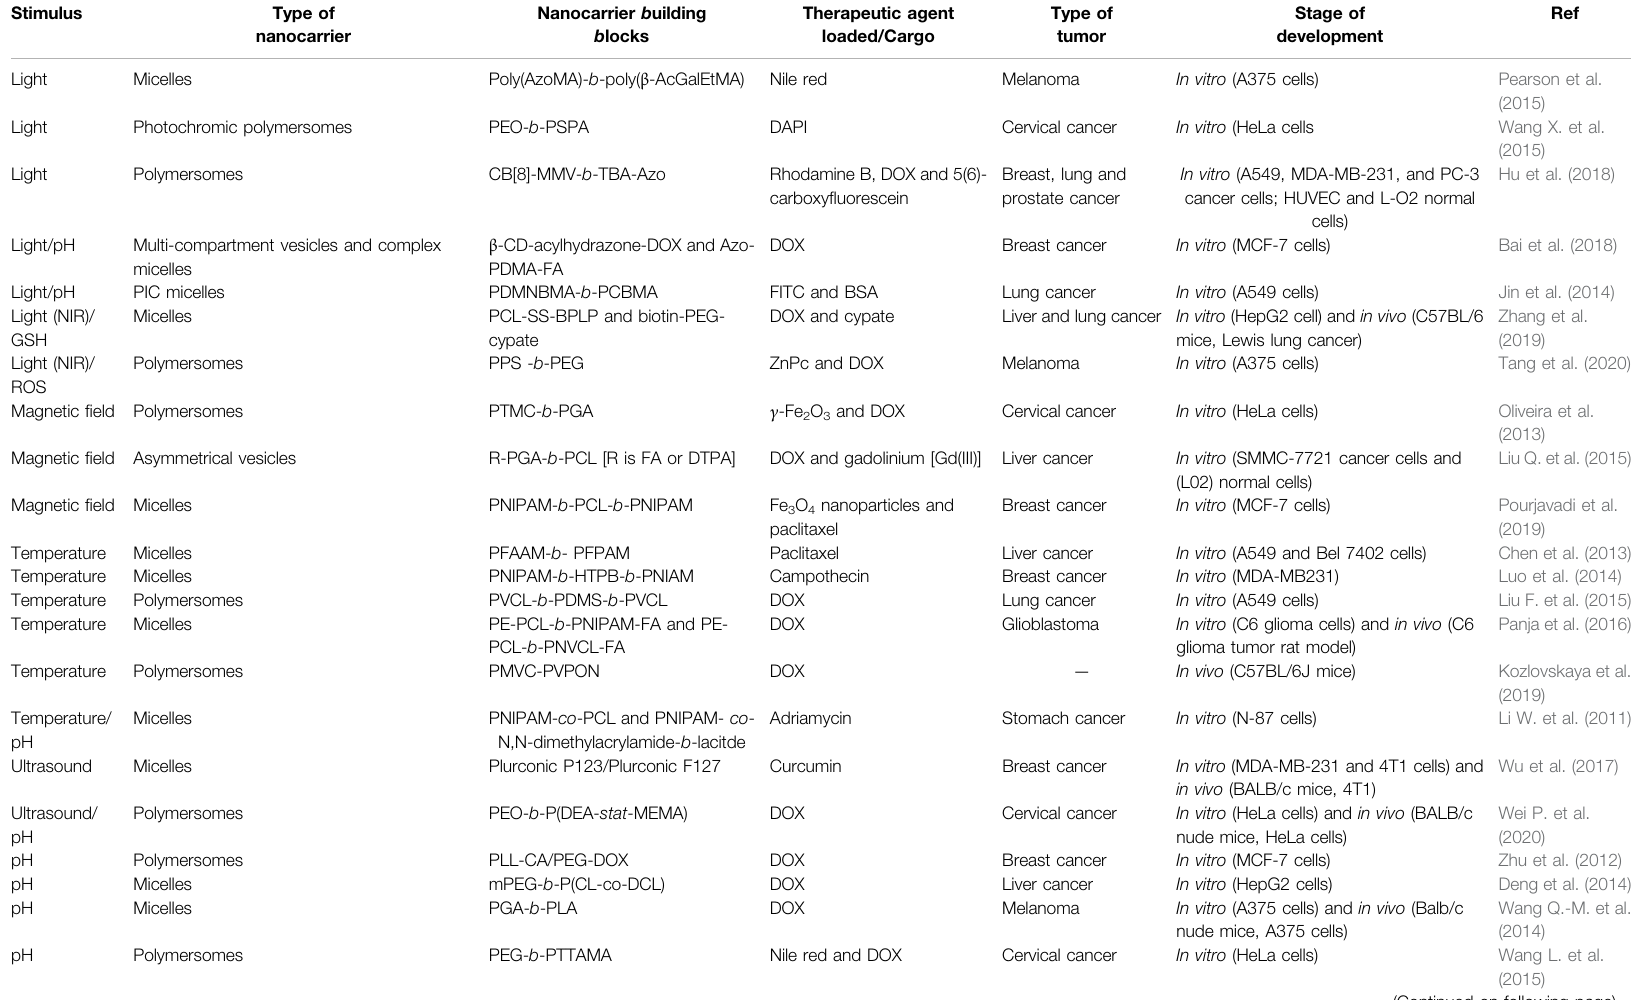
TABLE 1 | Amphiphilic block copolymers and stimuli-responsive self-assembly-based delivery systems for cancer therapy.